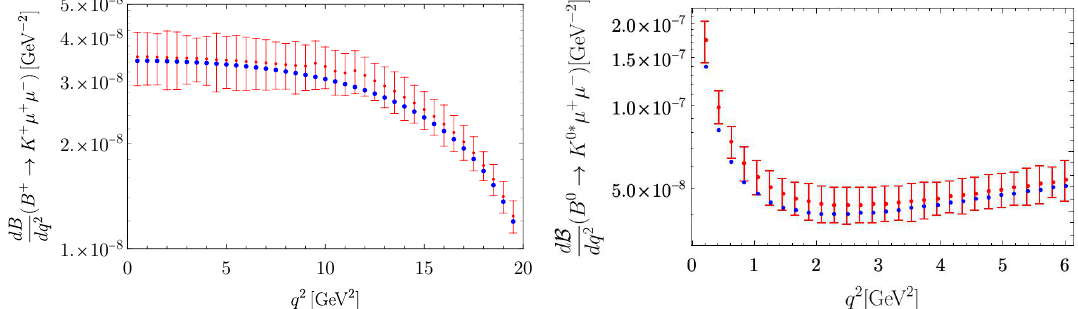
Figure 15. The SM prediction for the differential distributions obtained using Flavio (red dots) vs. our analytical formulas (blue dots). Error bars include the theoretical uncertainties in the SM